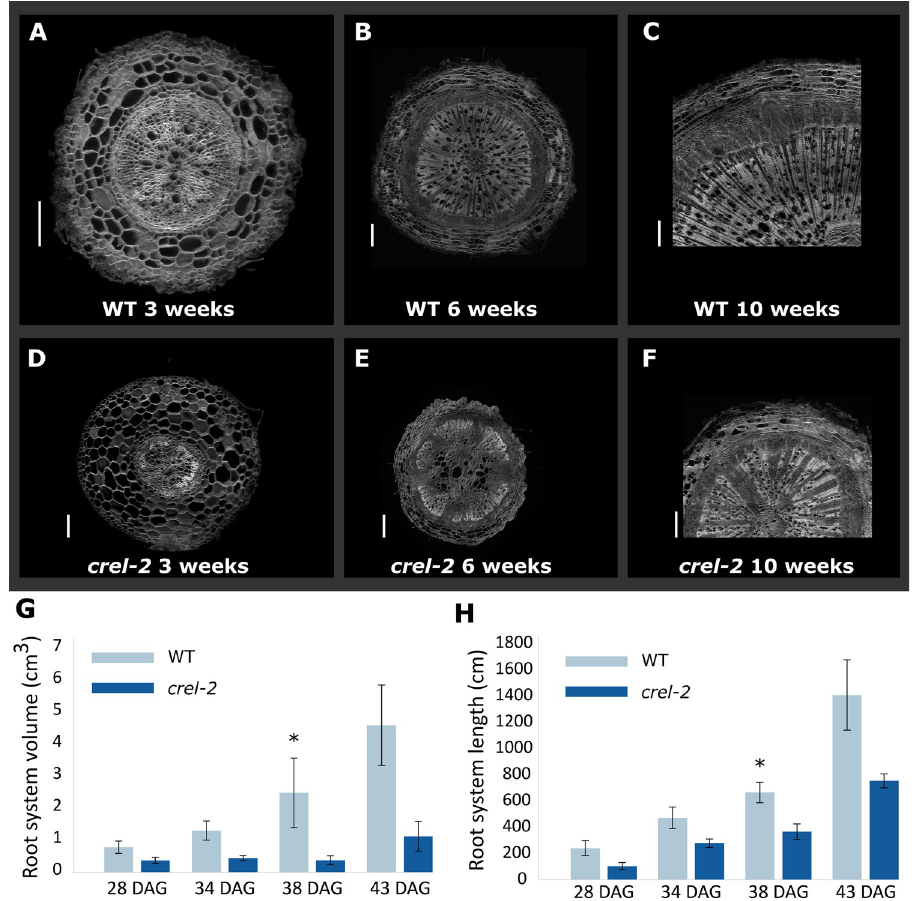
Fig 5. CREL promotes root development and differentiation. (A-F) Confocal images of root cross sections of the indicated genotypes dissected from the upper part of the primary root. Scale bars: 200 μ m (A, B, G); 500 μ m (C-F). (G) Root system volume at different times after germination, calculated with WinRhizo software. Shown are averages and SE of 3 plants (n = 3). Asterisks indicate statistically significant differences between crel-2 and WT, by Student’s t test, � p < 0.05. (H) Root system length at different times after germination (DAG), calculated withWinRhizo software. Shown are averages and SE of 3 plants (n = 3). Asterisks indicate statistically significant differences between crel-2 and WT, by Student’s t test, � p <